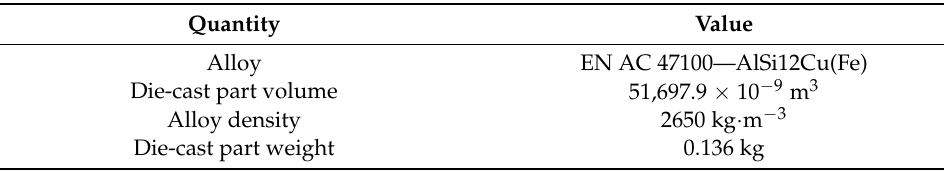
Table 4. Weight and volume characteristic of die-cast part.